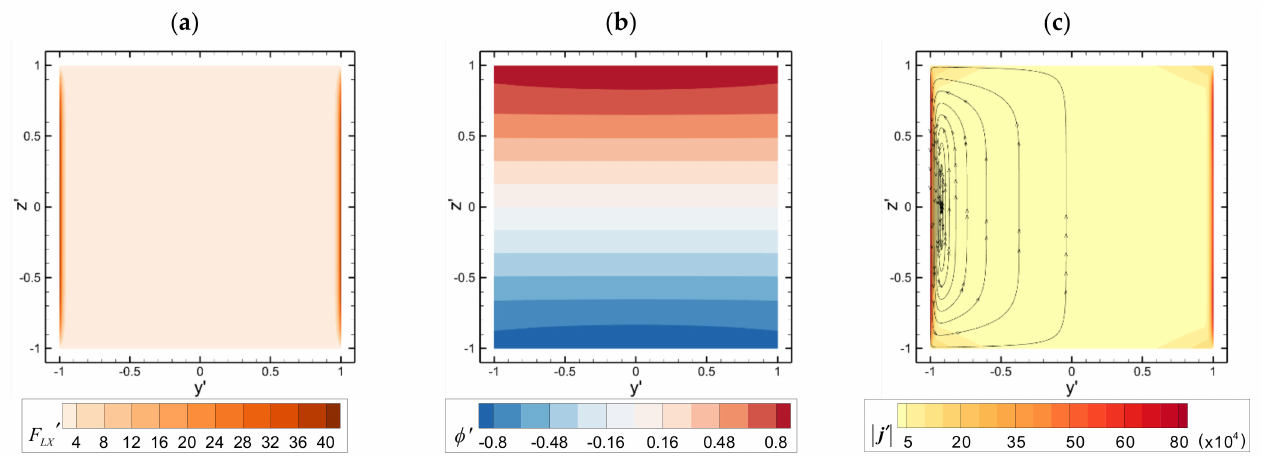
Figure 4. Normalized distributions of ( a ) the Lorentz force in the x -direction F LX (cid:48) , ( b ) the electric potential φ (cid:48) and ( c ) the magnitude of the electric current density (lines drawn only in the left half of the domain for clarity).